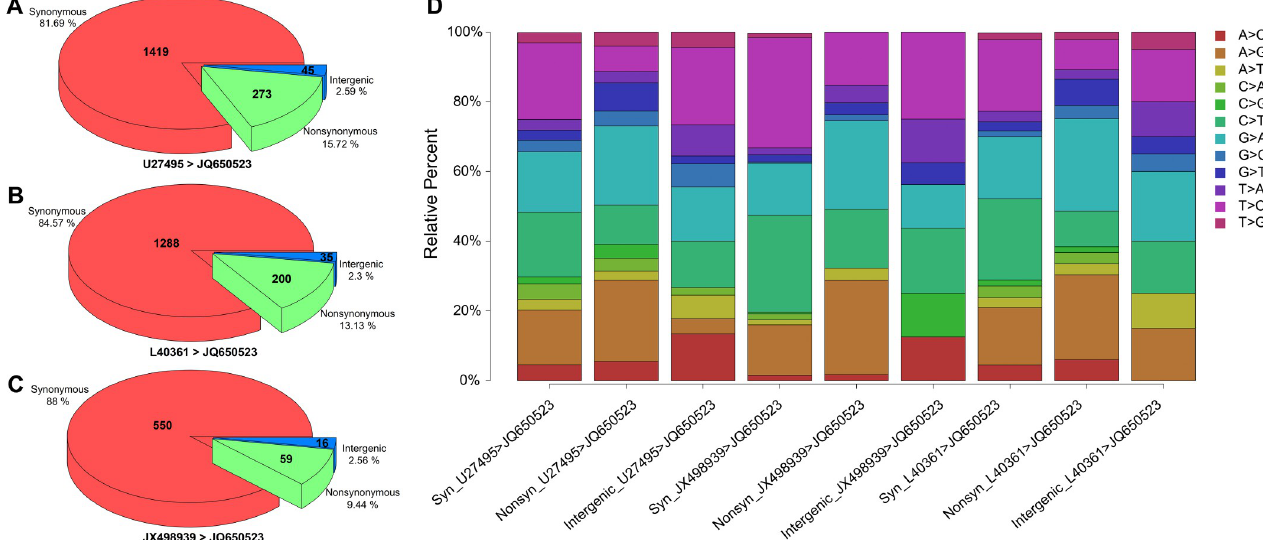
Fig 3. SNPs of Senzhang strain compared to reference strains. A: Distribution of SNP types of Senzhang strain compared to Neudoerfl strain. B: Distribution of SNP types of Senzhang strain compared to Vasilchenko strain. C: Distribution of SNP types of Senzhang strain compared to 205 strain. For A to C graph, the amount of SNPs was marked in the corresponding part of the pie diagram. D: Relative percentage of specific base substitution for SNPs of Senzhang strain compared to reference strains. Syn: Synonymous; Nonsyn: Nonsynonymous.